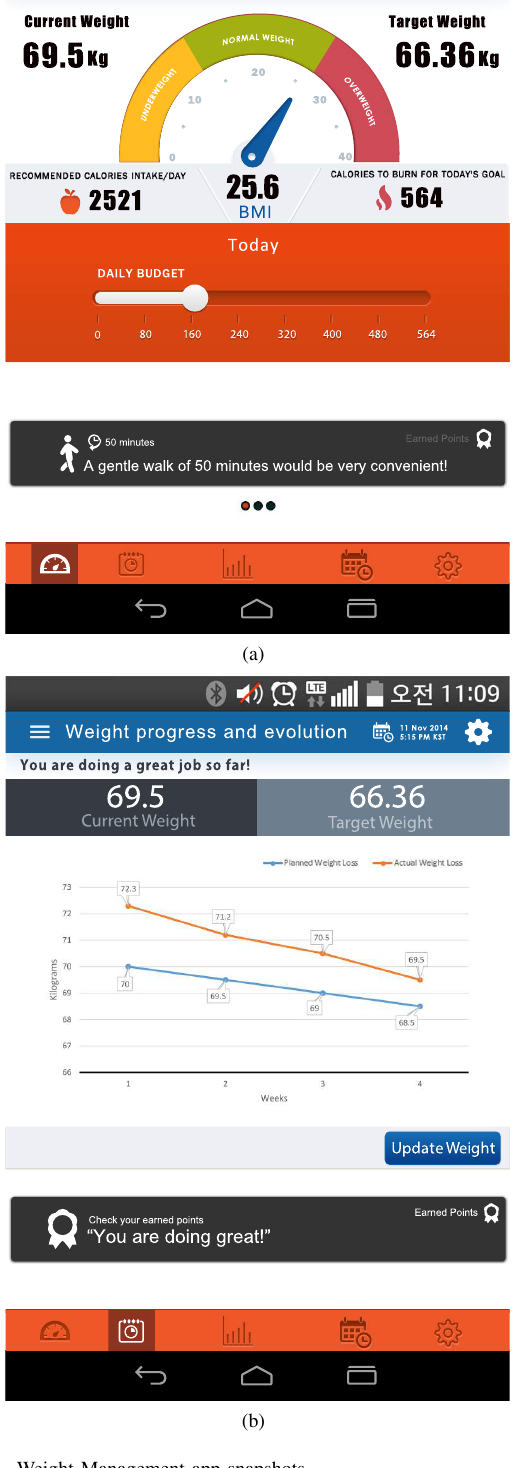
Fig. 2. Weight Management app